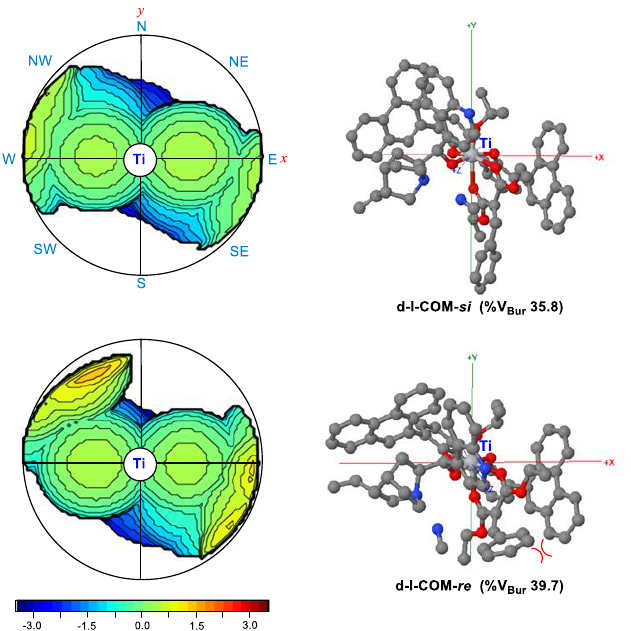
Scheme 4. Topographic steric maps for d-I-COM- si and d-I-COM- re . %V Bur is the percentage of buried volume, obtained by SambVca 2.1 software [45–47].